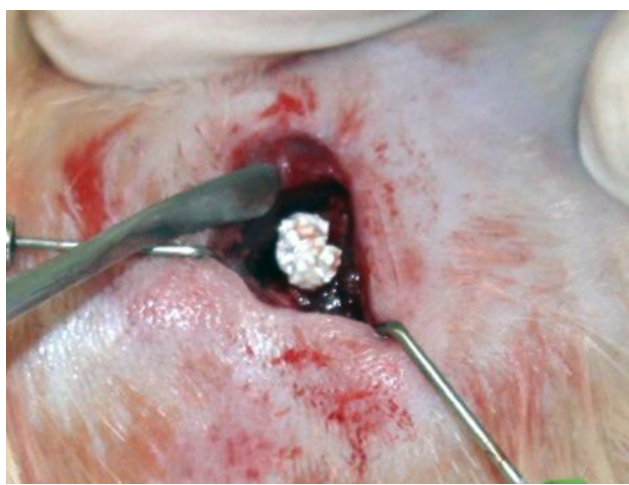
Figure 5. Implantation of the composite at the bone defect site.